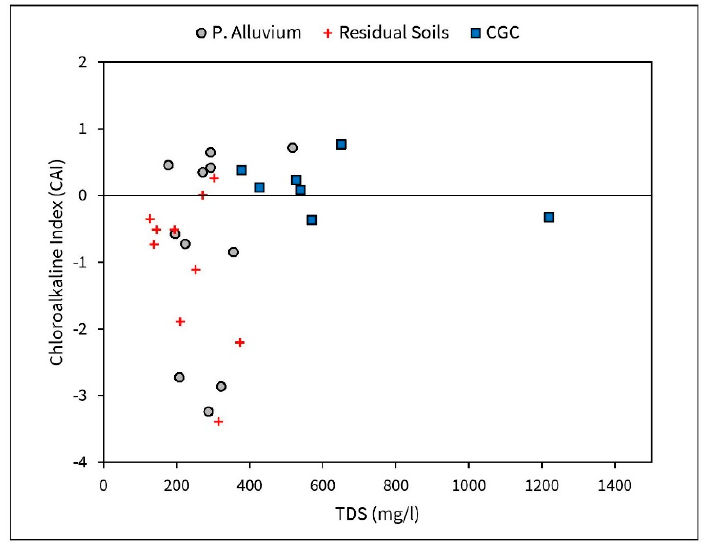
Figure 8. CAI vs. TDS plot; positive CAI indicates reverse cation exchange process, whereas a negative CAI indicates forward cation exchange process.